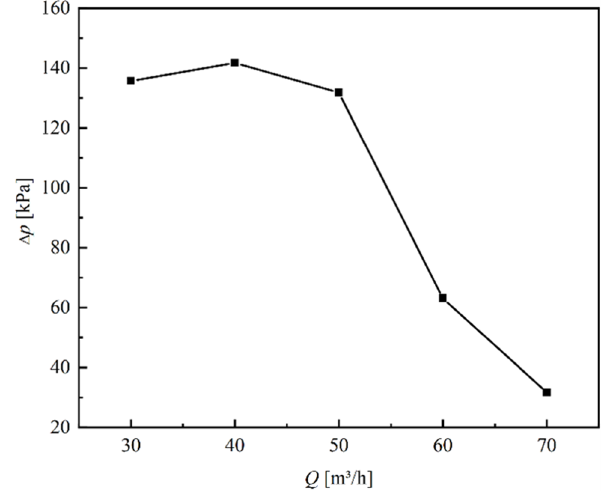
Figure 7. Influence of flow rate on pressure rise of a multiphase pump.